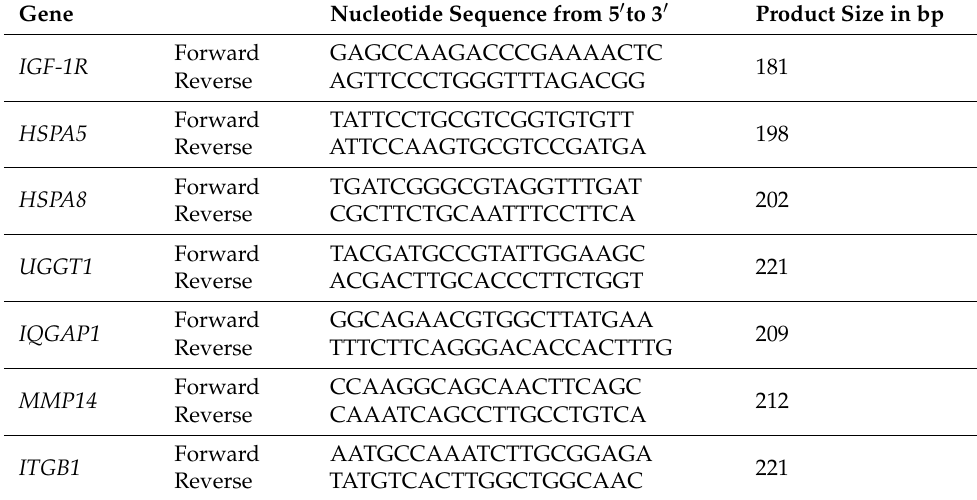
Table 3. Primers used for validation of the genes. Gene Nucleotide Sequence from 5 (cid:48) to 3